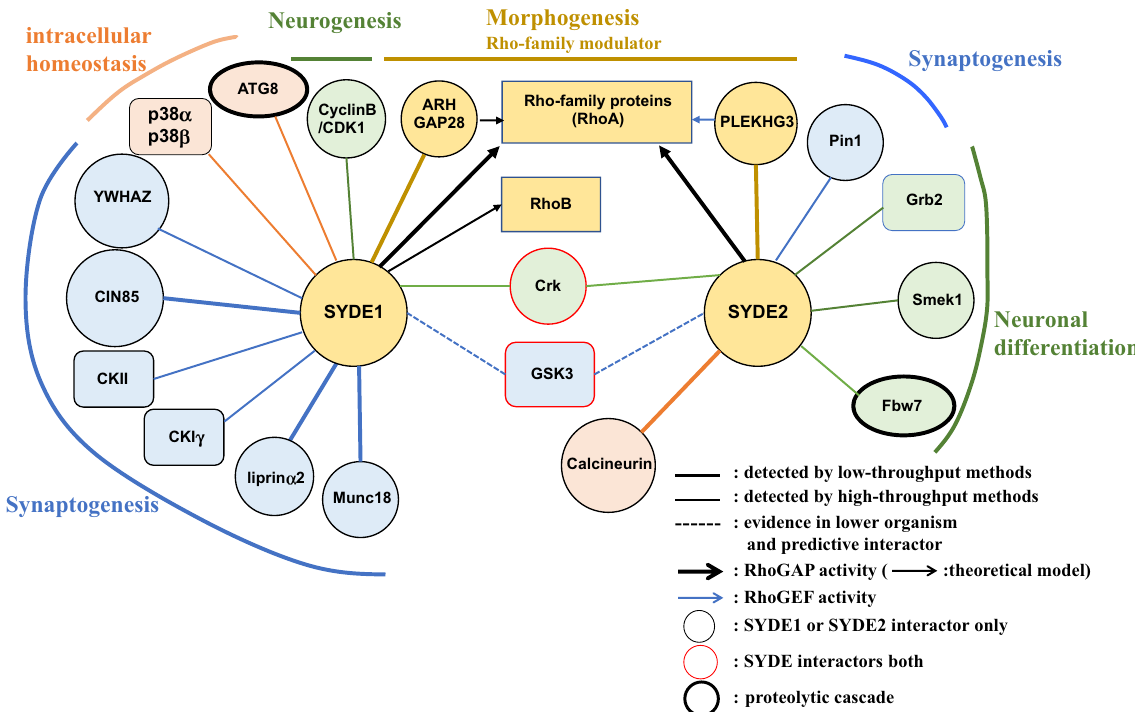
Figure 6. SYDE protein interaction network. SYDE binding partners identified by low-throughput data (bold line), high-throughput protein–protein interaction data or linear motifs prediction (thin line), and the interactions mediated by conserved sequences as linear motif that are predicted to be associated with binding partner proven in lower organism (dotted line). Interactors are represented by different shapes based on their molecular function: protein kinases (rectangles); degradation machineries (bold-lined ovals); adaptor proteins or phosphatases (circles). Interactor is colored and categorized by neuronal regulatory function as follows: Rho-family modulators (yellow); synaptogenesis (light blue); intracellular homeostasis (light pink); neuronal differentiation (green). SYDE interactor both is marked by red edges and either SYDE1 or SYDE2 only binding partner is represented by black edges. CKIγ casein kinase Iγ, CKII casein kinase